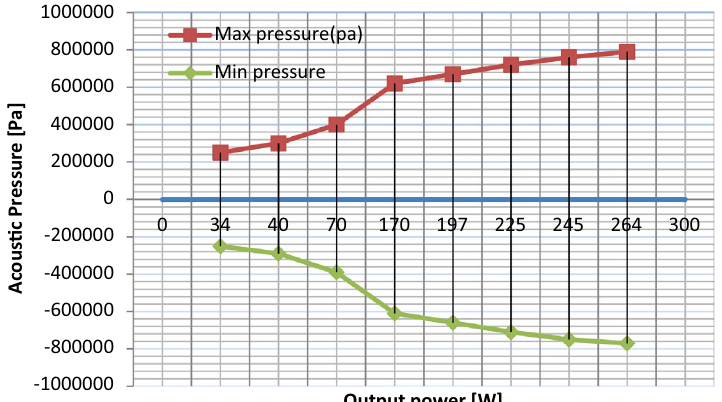
0.811.21.41.61.822.2